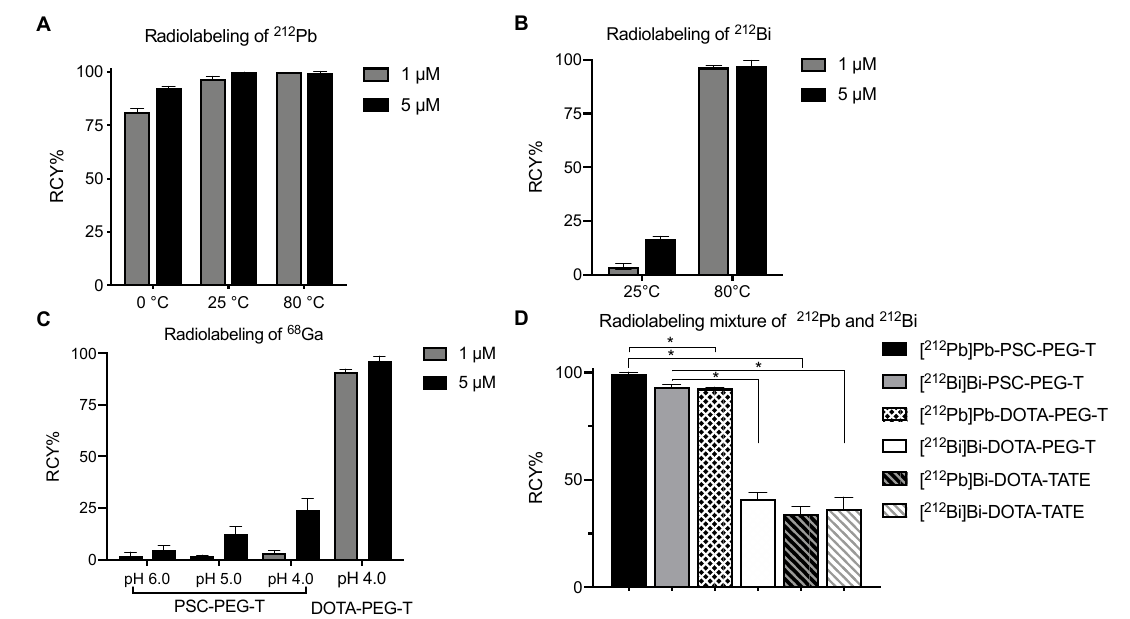
Figure 2. PSC chelator reacts with borderline Pb(II) and Bi(III), but not with hard Ga(III). Radio- labeling reaction yield of single species of ( A ) 212 Pb, ( B ) 212 Bi, and ( C ) 68 Ga 3+ in PSC-PEG-T was mon- itored by radio-iTLC method; ( D ) Incorporation of mixture of 212 Pb and 212 Bi simultaneously with 212 Pb/ 212 Bi at equilibrium in 5 µM PSC-PEG-T, DOTA-PEG-T and DOTA-TATE. Data presented as mean ± S.D. (n = 2). * p < 0.05 by two-tailed t test.